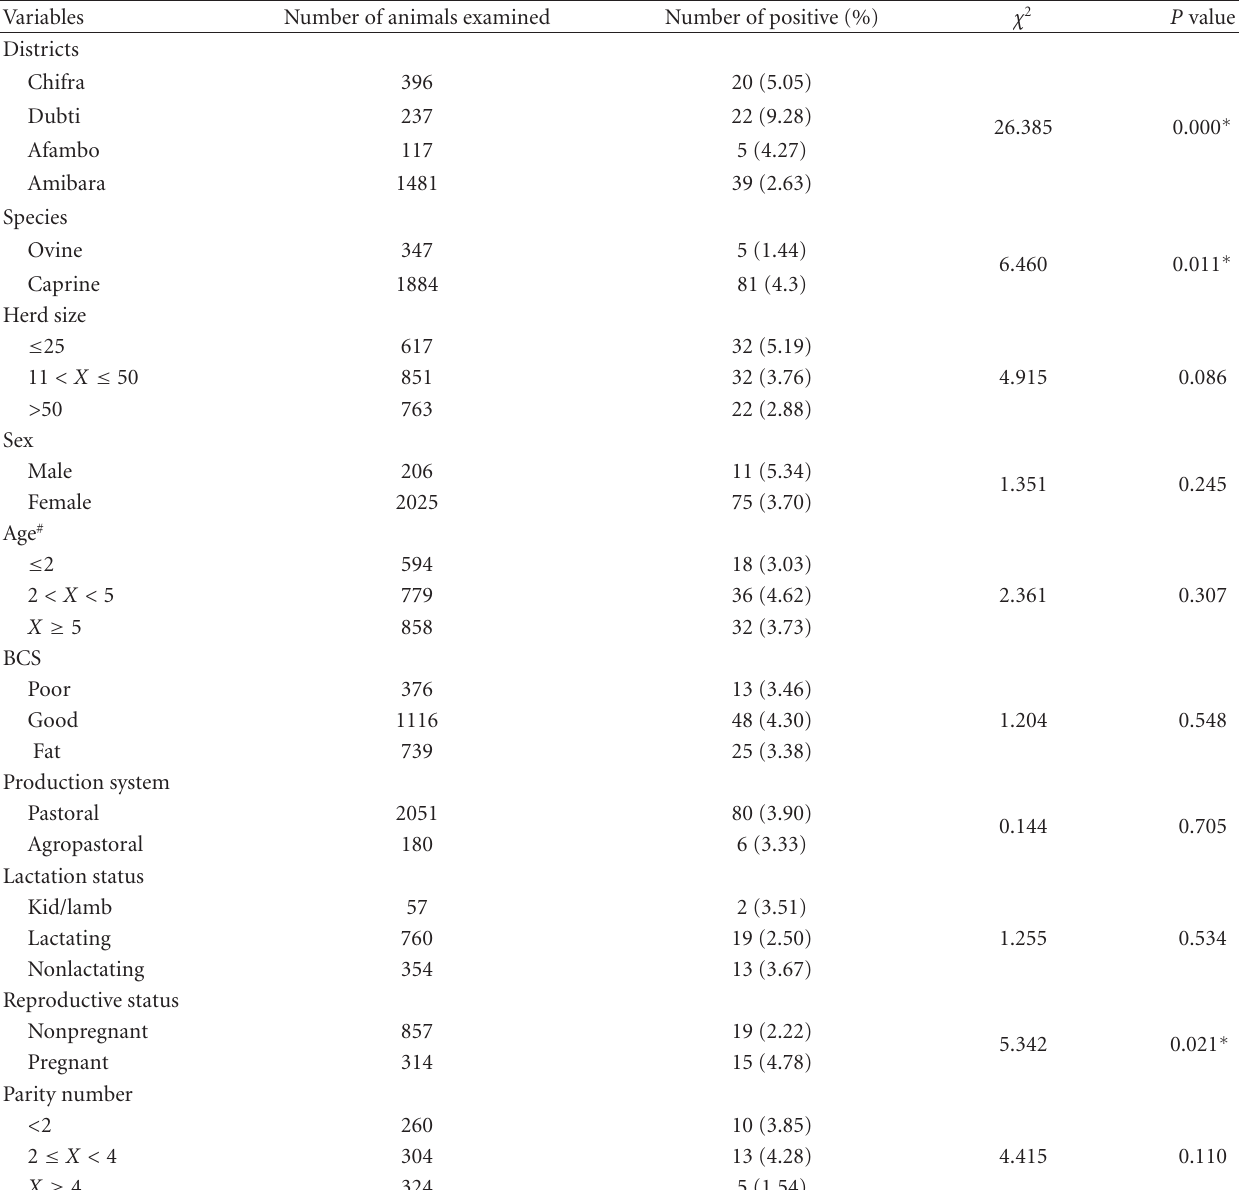
Table 1: Association of di ff erent risk factors to skin test positivity at ≥ 2 mm cut-o ff point for small ruminant tuberculosis in Afar Pastoral Region of